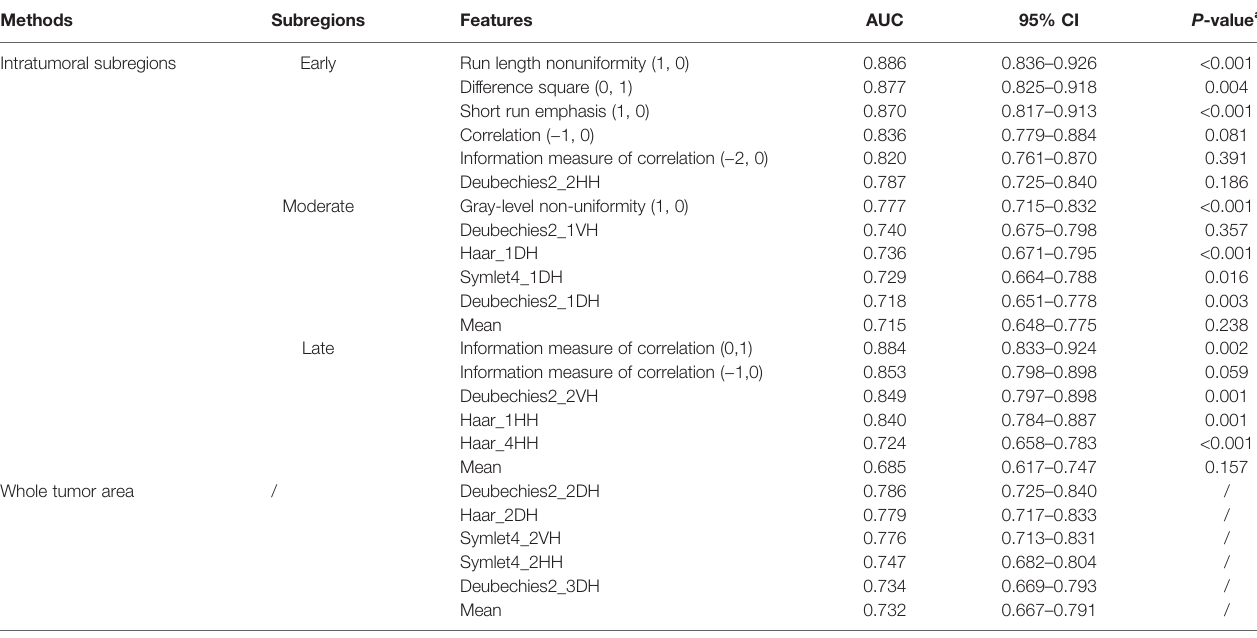
TABLE 3 | Univariate analysis for predicting benign and malignant breast tumors.